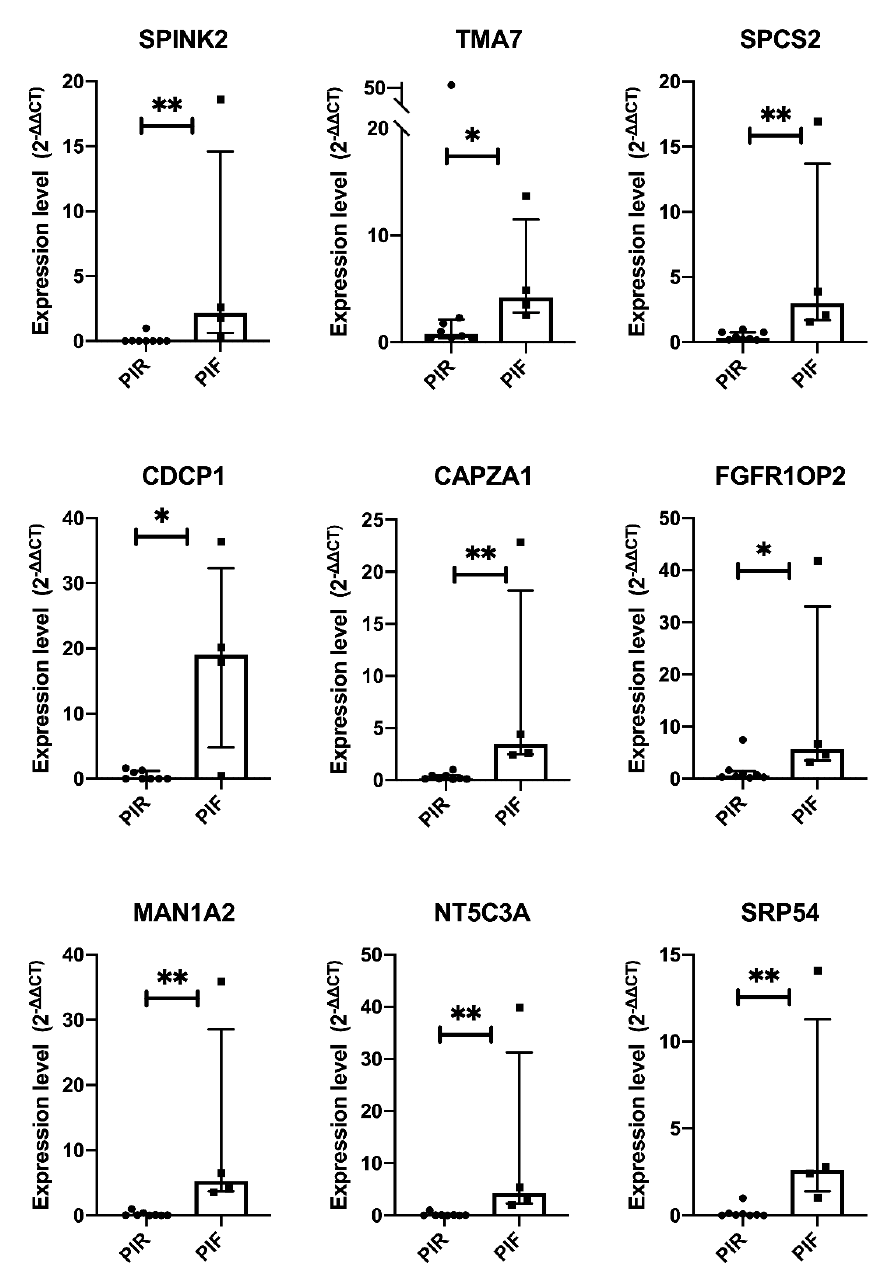
Figure 4. Quantitative Real Time RT-PCR of selected transcripts in local pediatric AML cohort. Statistical differences between PIF and PIR patients were assessed using the Mann-Whitney test p -value. * p < 0.05, ** p < 0.01.